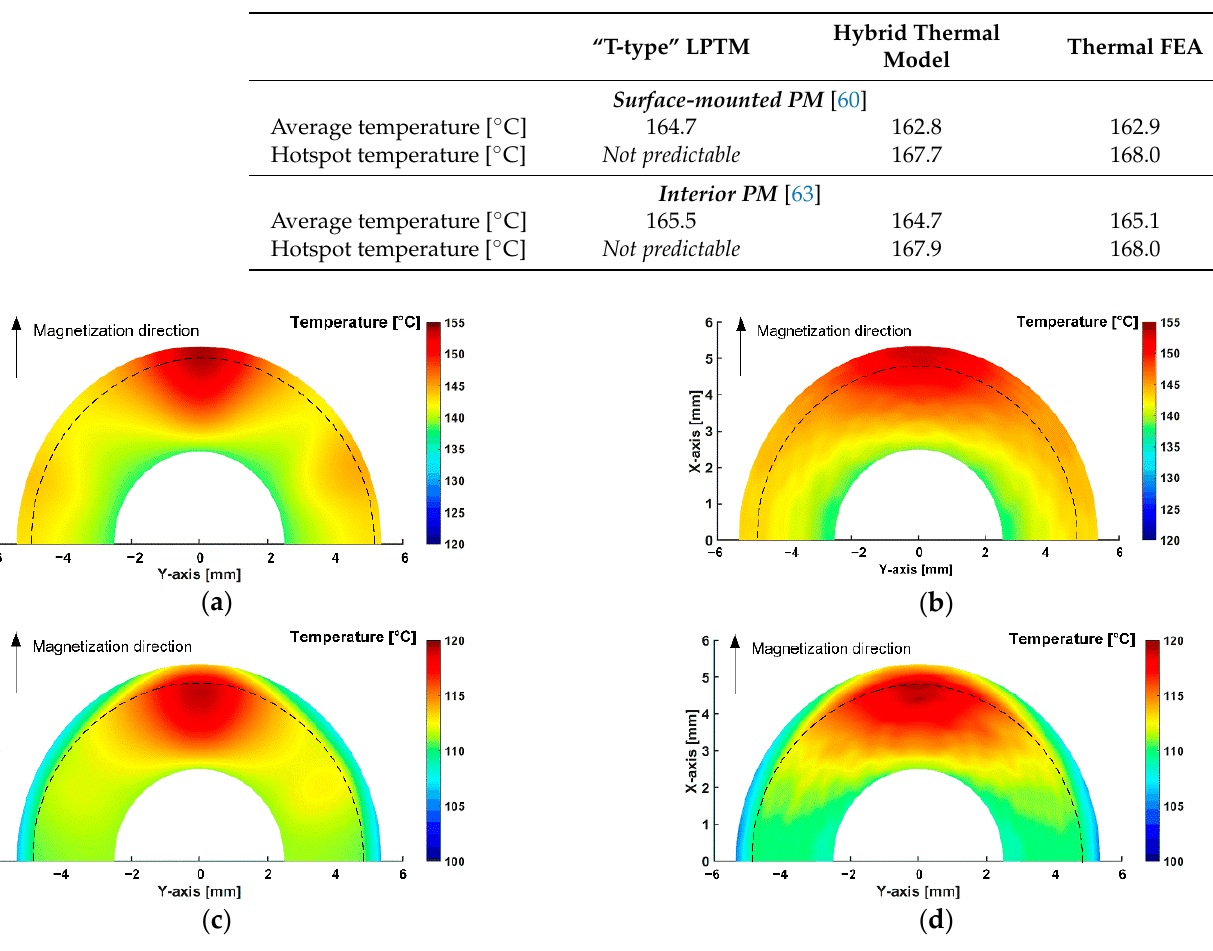
Figure 27. Steady-state rotor temperatures in r - θ plane considering retaining sleeves [62] (dashed